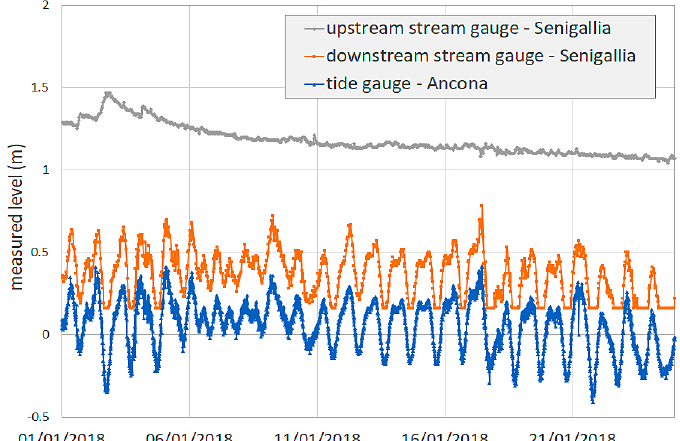
Figure 2. Water elevation measured by stream gauges located at “Bettolelle” (~9 km from the mouth, gray) and near “Ponte Garibaldi” (~1.5 km from the mouth, orange), both referring to a local reference system. Comparison is made with observations from the tide gauge located at Ancona harbor (blue).